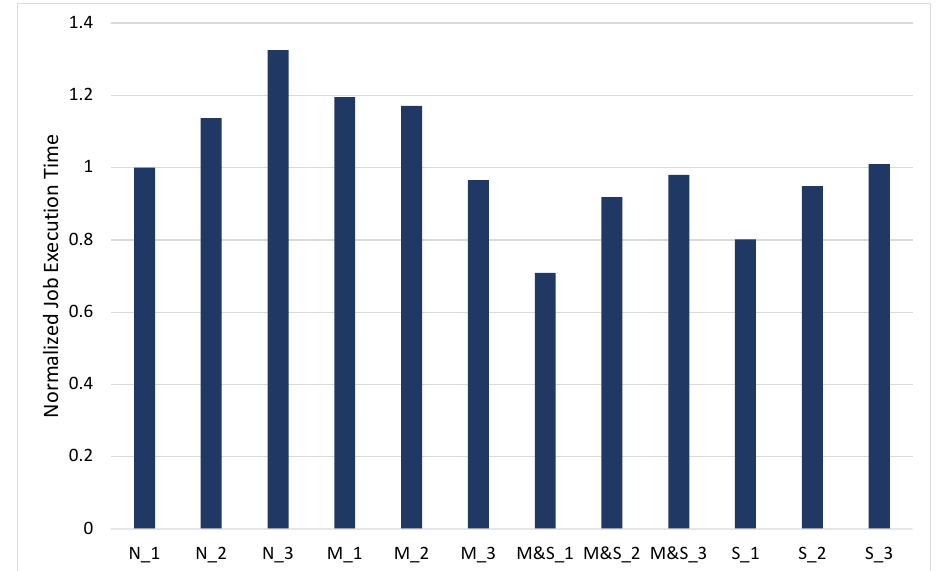
Figure 4. The normalized PageRank job execution time for 500 MB